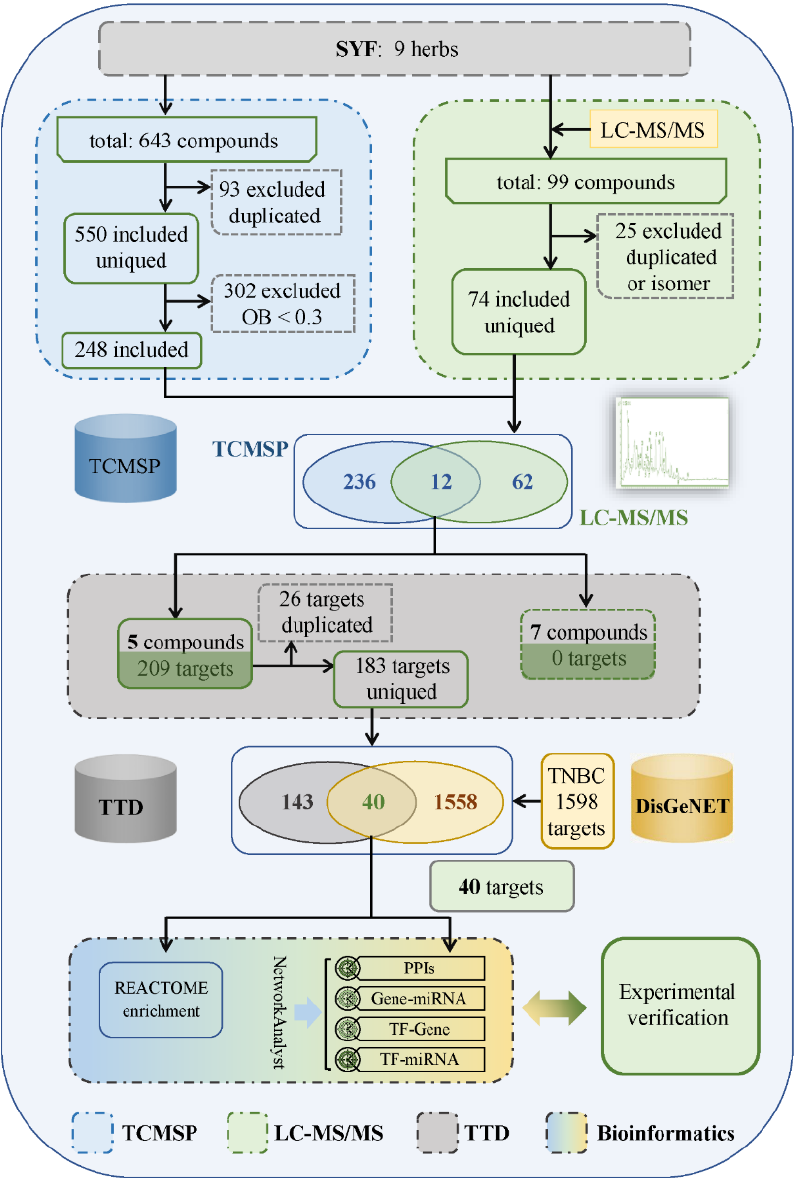
Figure 2. Flowchart of the network pharmacology and bioinformatic analysis approach.